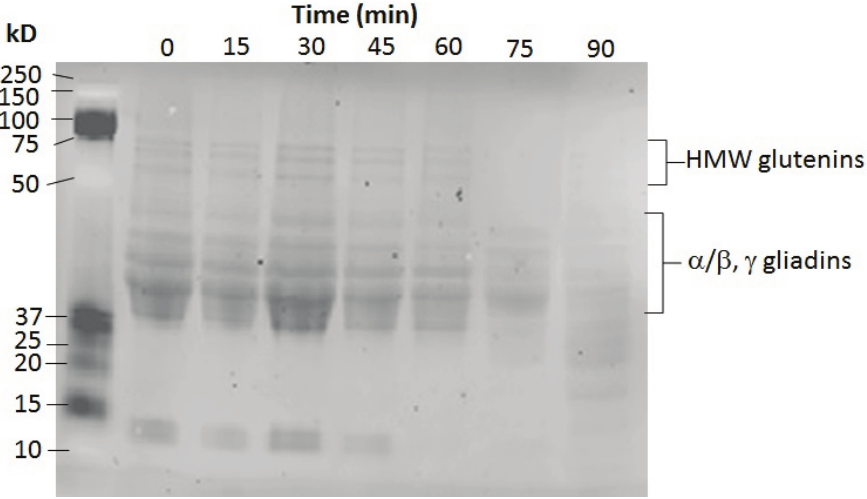
Figure 8. SDS PAGE analysis of the digestion of total gluten by spPEP. spPEP (60 μg) was incubated with 400 μg of total gluten for a total of 90 min at 37 °C. Every 15 min, a volume of the reaction that would contain 50 μg of gluten was removed, added to 6× Laemmli sample buffer, heated and loaded onto the gel. The molecular weight marker was the Kaleidoscope marker from Bio-Rad